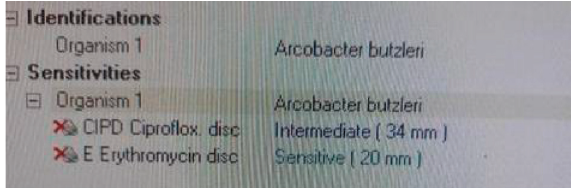
Figure 2: Sensitivities of identified A. butzleri in our patient.